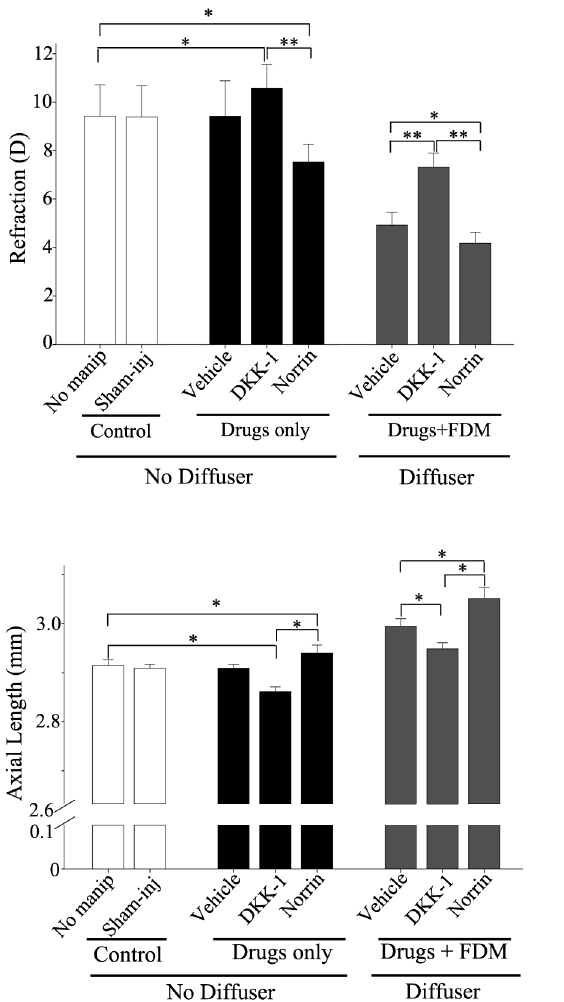
Figure 5.Wnt pathway is involved in the development of FDM. Intravitreal drug administration began on the second day of occlusion and was repeated every three days for a total of four times (2nd, 5th, 8th and 11th days of FD). A total of 3 m l of DKK-1 (10 ng/ m l) or Norrin (5 ng/ m l) was injected into the vitreous chamber each time. Refraction and axial length were measured 3 days after the last injection. There were no differences, neither between no-manipulation (‘‘no-manip’’ in the figure) and sham-injection (‘‘sham-inj’’ in the figure), nor between these and injection with vehicle in the drugs-only group. DKK-1 significantly reduced the time-dependent increases in axial length, and significantly increased refractions (made them more positive or hyperopic), while Norrin had the opposite effect. Six mice were used in each group. Data are presented as mean 6 SEM.(* P , 0.05 and ** P , 0.01).